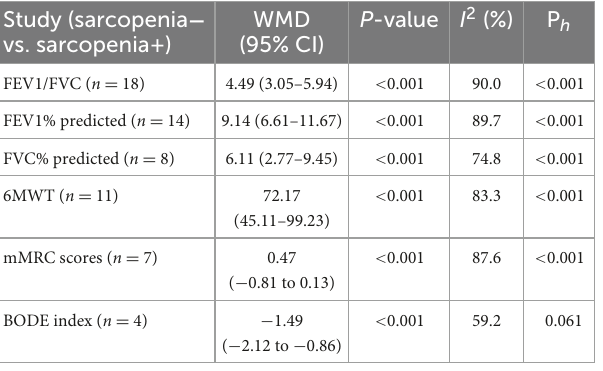
TABLE 3 Meta-analysis, differences regarding lung function, 6MWT, mMRC, and BODE index between patients with and without sarcopenia. Study (sarcopenia −